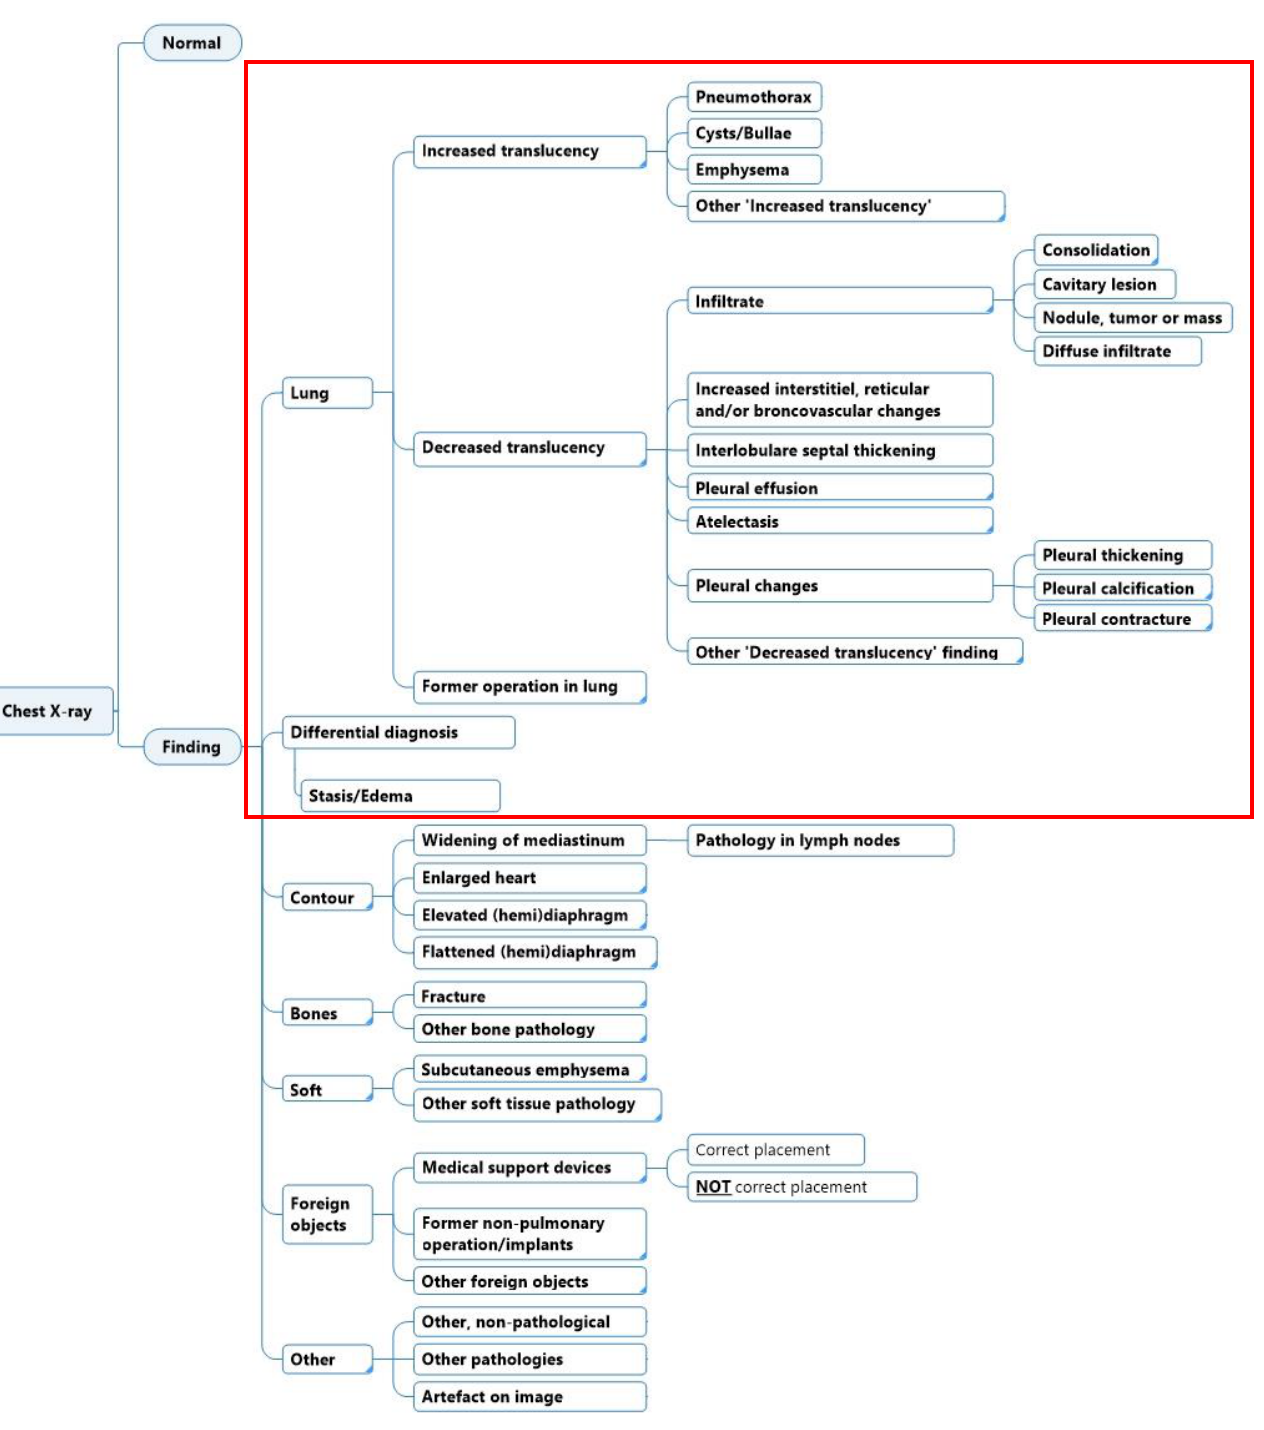
Figure 6. Proposed diagnostic labeling scheme for lung tissue findings (red square) on chest X-ray where interpretive labels have been replaced with more descriptive labels (corresponds to the labels encased with a red square in Figure